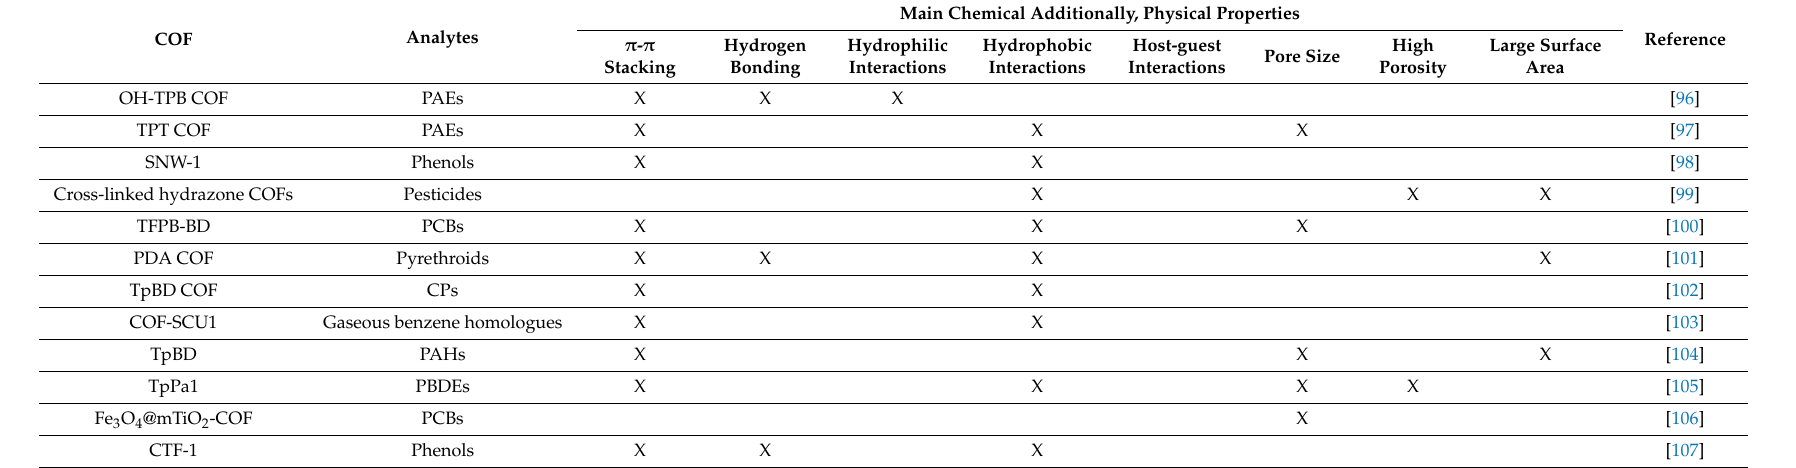
Table 4. Main chemical and physical properties influencing the extraction e ffi ciency of COFs used in SPME and